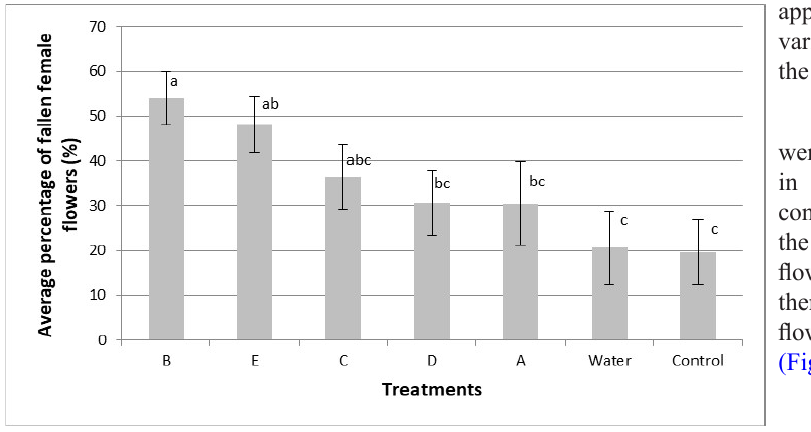
Figure 1. Average percentage of fallen flowers, standard error and Tukey test for the different treatments. La Molina, Lima-Perú. 2008.